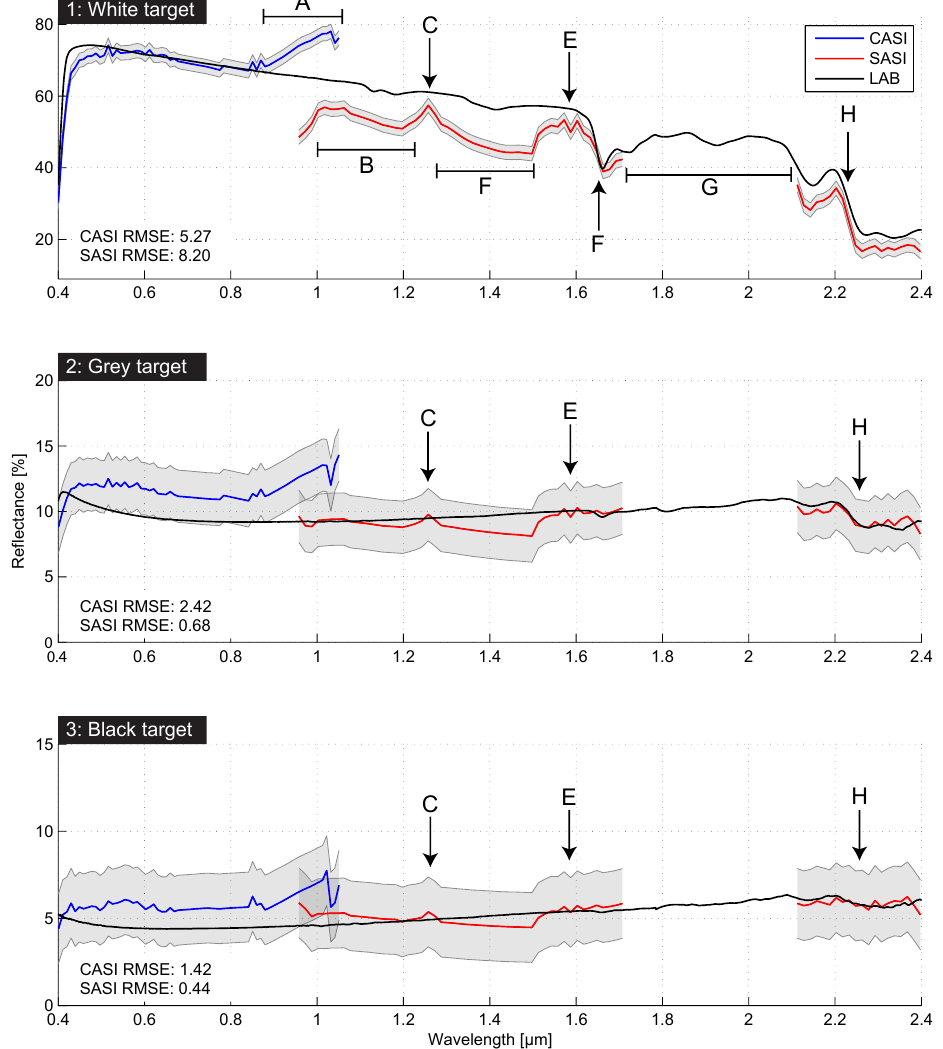
Figure 7. Atmospheric correction results for the VNIR (CASI; blue) and SWIR (SASI; red) data ( ± 2% error estimates are shaded grey) and laboratory spectra (LAB; black), for the three calibrated targets; white ( 1 ); grey ( 2 ); and black ( 3 ). Labels are discussed in the text. Root Mean Square Error (RMSE) values are shown for each